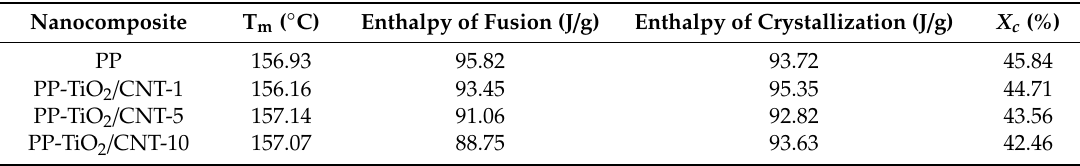
Table 4. Di ff erential scanning calorimetry (DSC) date for polypropylene (PP) and